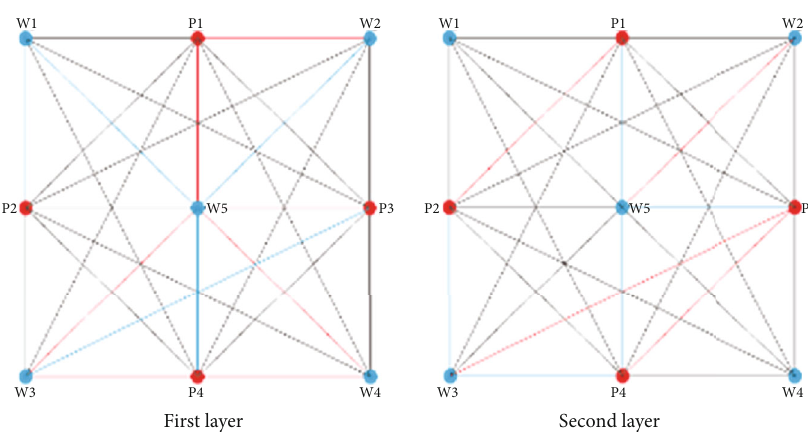
Figure 3: Streamline fi eld in FrontSim.